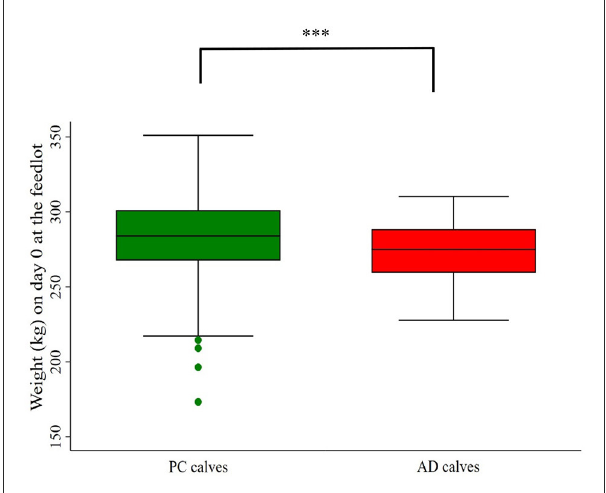
FIGURE4 Body weight of calves on day 0 at the feedlot. PC, preconditioned calves. AD, auction-derived calves; ***Difference ( P < 0.001).